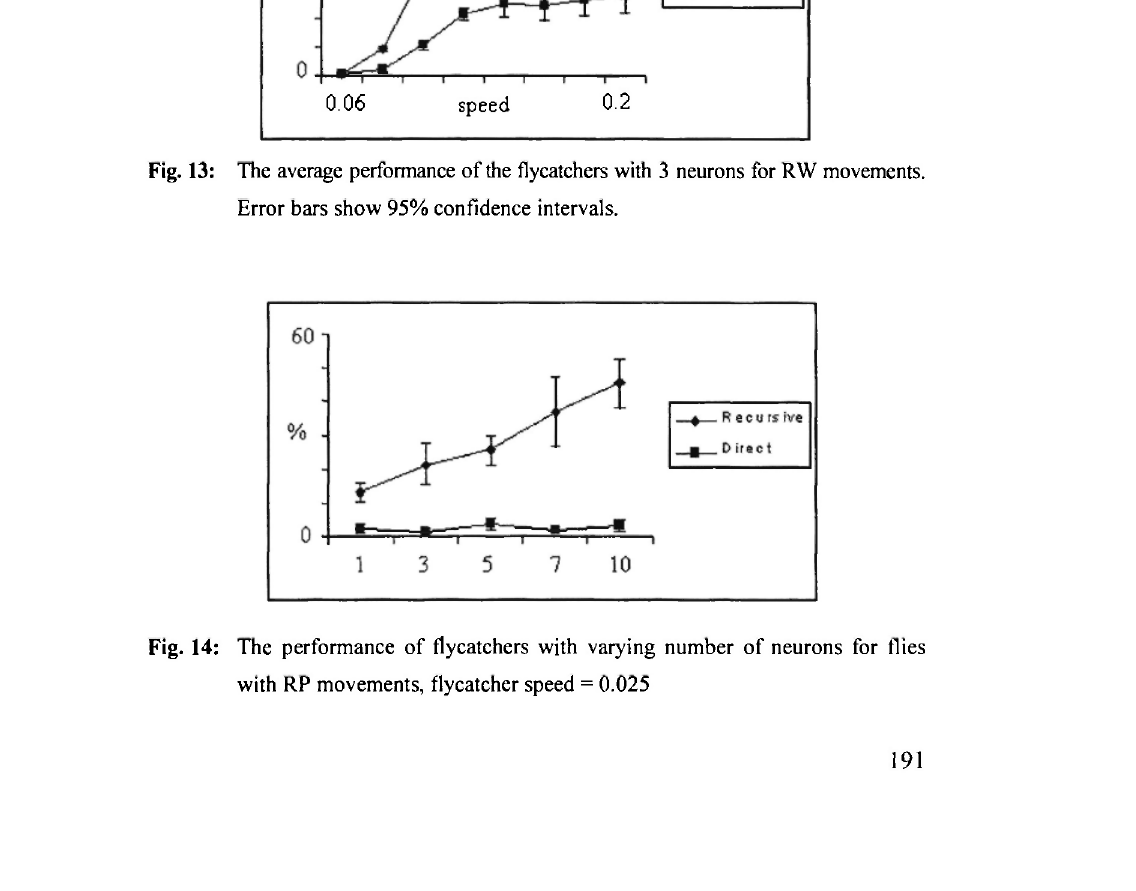
Fig. 13: The average performance of the flycatchers with 3 neurons for RW movements. Error bars show 95% confidence intervals.